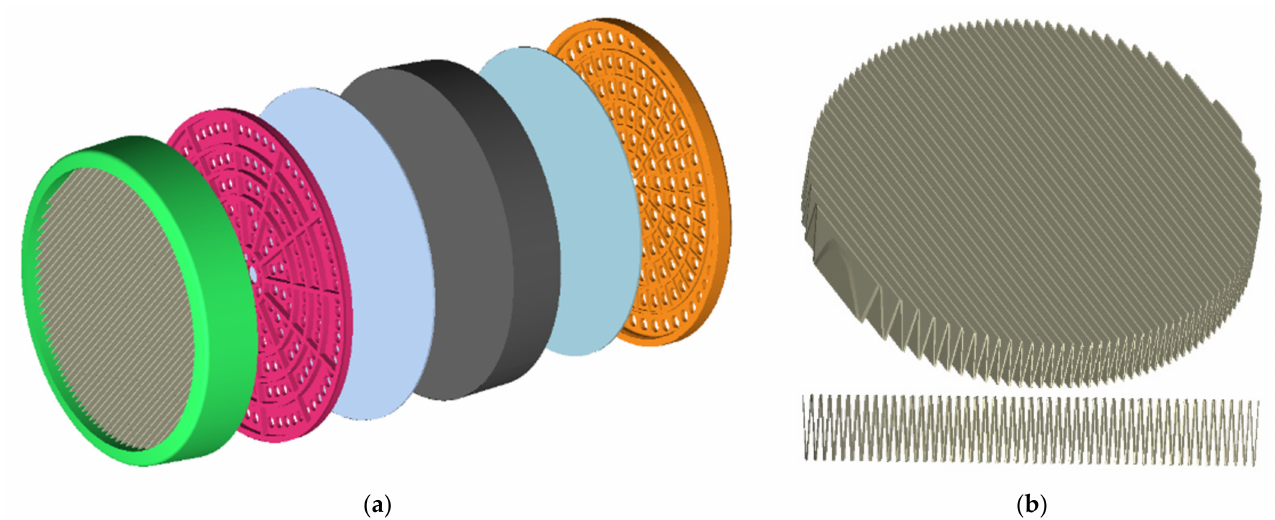
Figure 2. Components inside combined filter. ( a ) From left to right: zig-zag-shaped pleated filter with sealing, first perforated screen, first textile divider, absorbent filling, second textile divider, second perforated screen; ( b ) Detail of zig-zag-shaped pleated